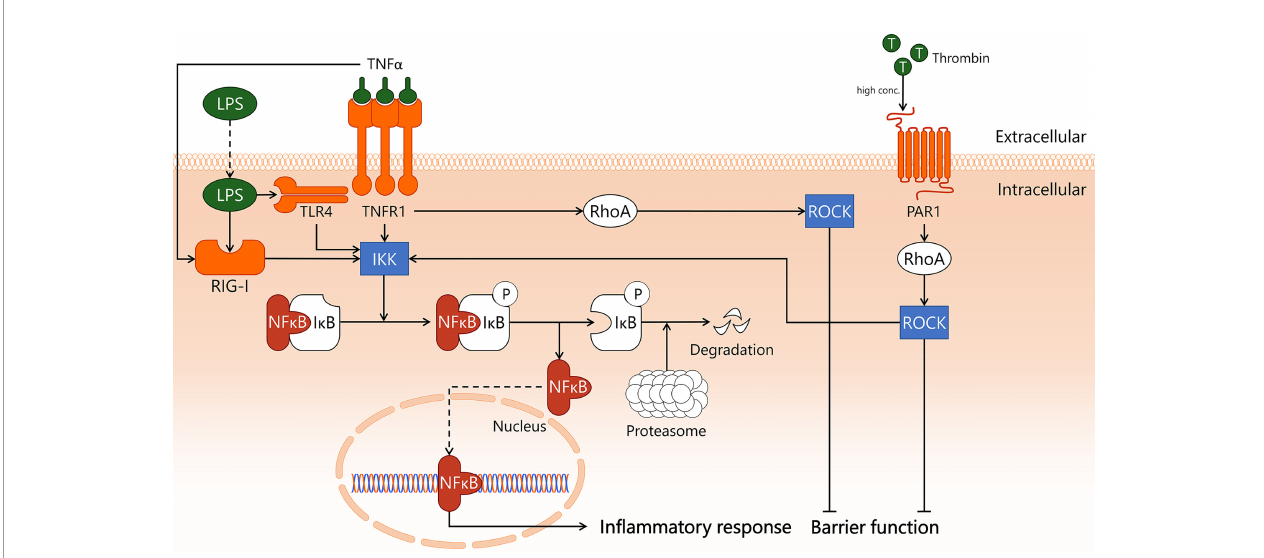
FIGURE 1 | Transcription factor NF- k B induces endothelial in fl ammation during sepsis. In sepsis, endothelial cells are exposed to pro-in fl ammatory cytokine TNF a and Gram-negative bacterial product LPS, which incite pro-in fl ammatory responses. TNF a binds to its receptor TNFR1, activating both IKK and RhoA. TNF a also activates intracellular receptor RIG-I through unknown mechanisms. LPS is taken up by the cell, where it is recognised by both TLR4 and RIG-I, which activate IKK. High levels of thrombin induce PAR1-dependent activation of RhoA, which also activates IKK. In quiescence, I k B masks the nuclear translocation signal of NF- k B, hereby retaining it in the cytosol. Upon activation of IKK, I k B is phosphorylated and dissociates from NF- k B. While I k B is then enzymatically degraded by proteasomes, freed NF- k B translocates to the nucleus to incite an in fl ammatory response. In addition, the endothelial barrier function is negatively affected, following TNFR1- and PAR1-dependent activation of RhoA. IKK, I k B kinase; I k B, inhibitor of k B; LPS, lipopolysaccharide; NF- k B, nuclear factor kappa-light-chain-enhancer of activated B cells; PAR1, protease-activated receptor 1; RhoA, Ras homolog gene family, member A; RIG-I, retinoic acid-inducible gene I; ROCK, Rho-associated protein kinase; T, thrombin; TLR4, Toll-like receptor 4; TNFR1, tumor necrosis factor alpha receptor 1; TNF a , tumor necrosis factor